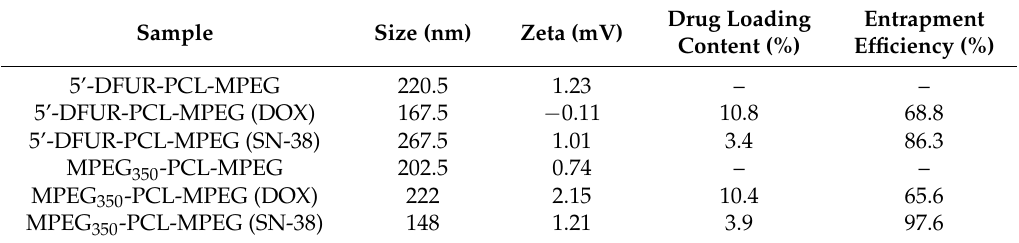
Table 2. Characteristics and drug loading of 5’-DFUR-incorporated polymeric